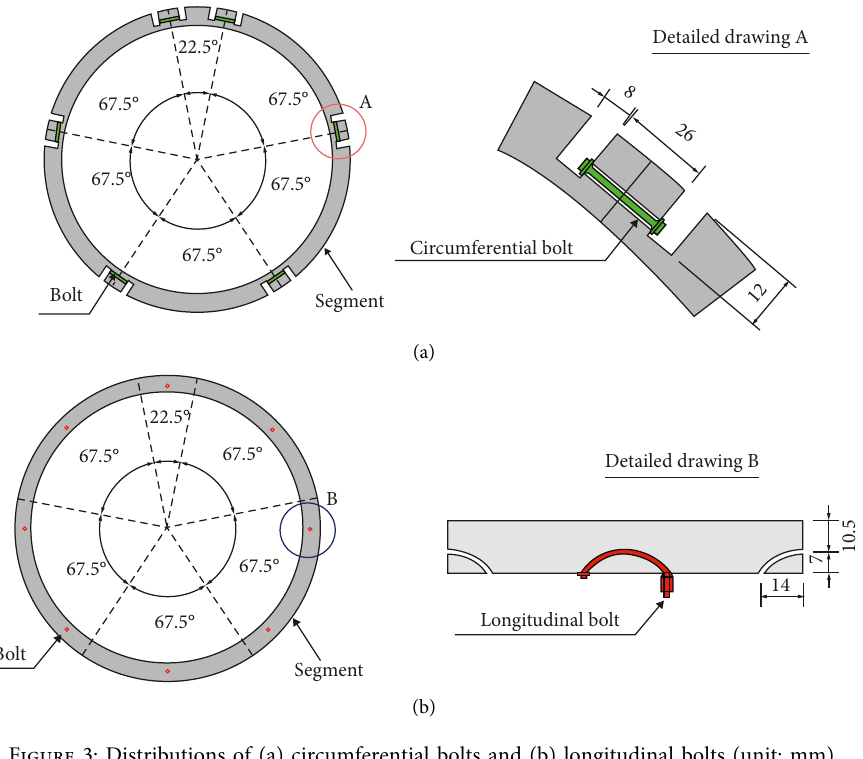
Figure 3: Distributions of (a) circumferential bolts and (b) longitudinal bolts (unit: